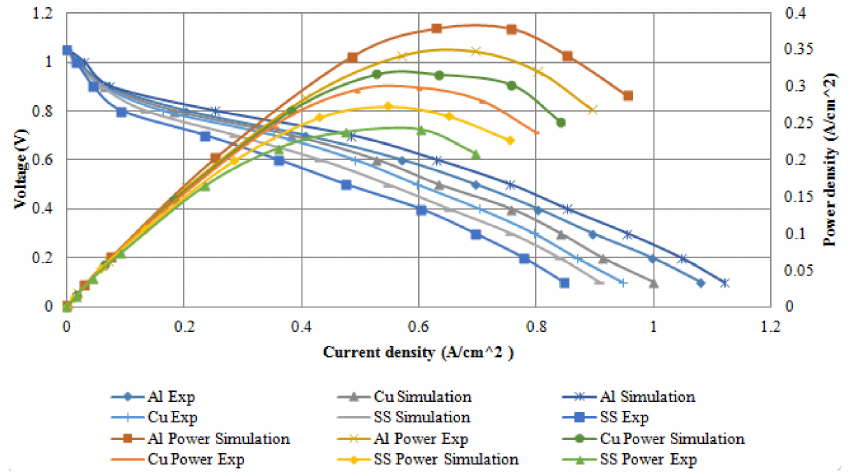
Figure 19. Comparison between numerical and experimental results of various bipolar plate